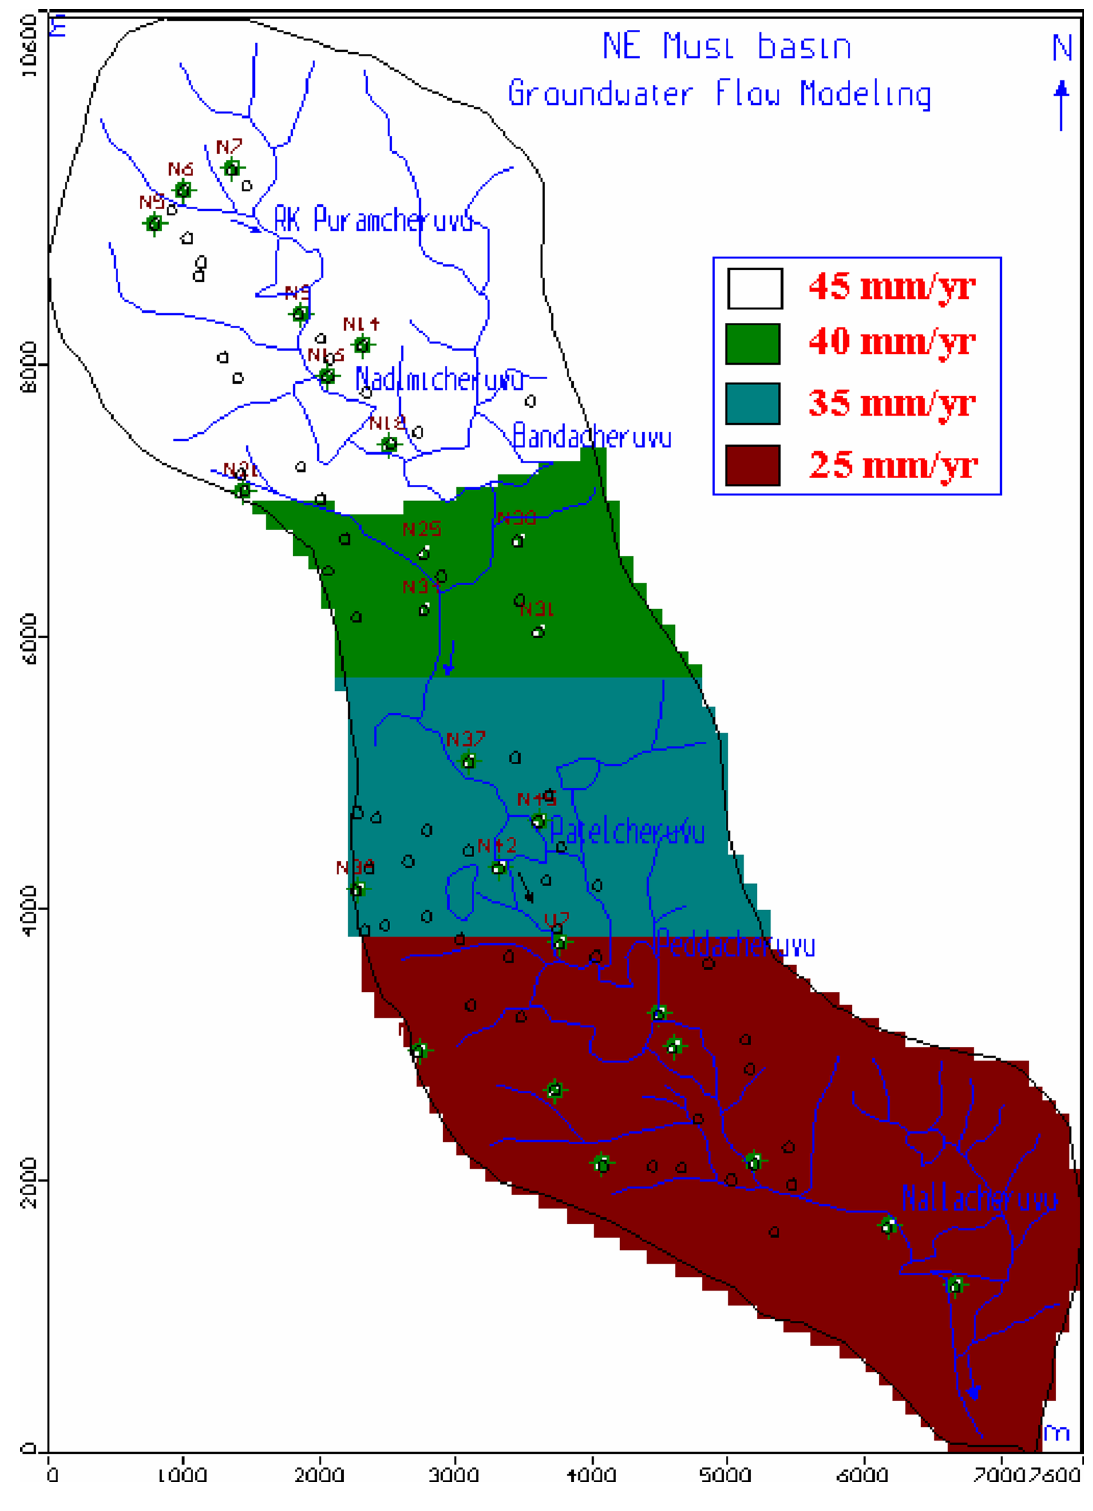
Fig. 6 Calibrated block-wise